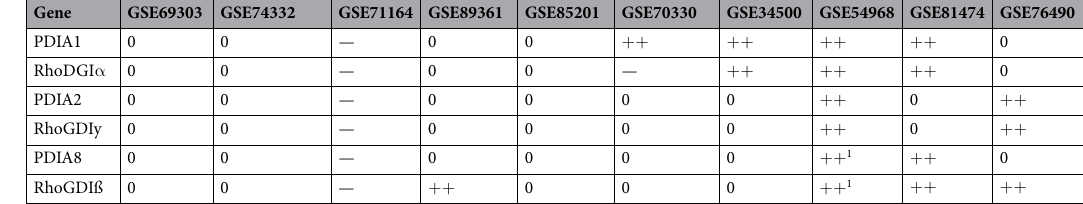
Table 4. Analysis of transcription, inducibility of the gene pairs and binding of transcription factors to the genes indicated. 0 = no expression difference; −− = decreased; ++ = induced;1with an intermediate peak at day8; GSE69303, Vitamin D; GSE74332, blood- versus lymphatic-HMVECs; GSE71164, Fluid shear stress; GSE85201, Jurkat PMA/Ionomycin; GSE70330, Hypoxia; GSE34500, p65/Pol II TNFa; GSE54968, EC